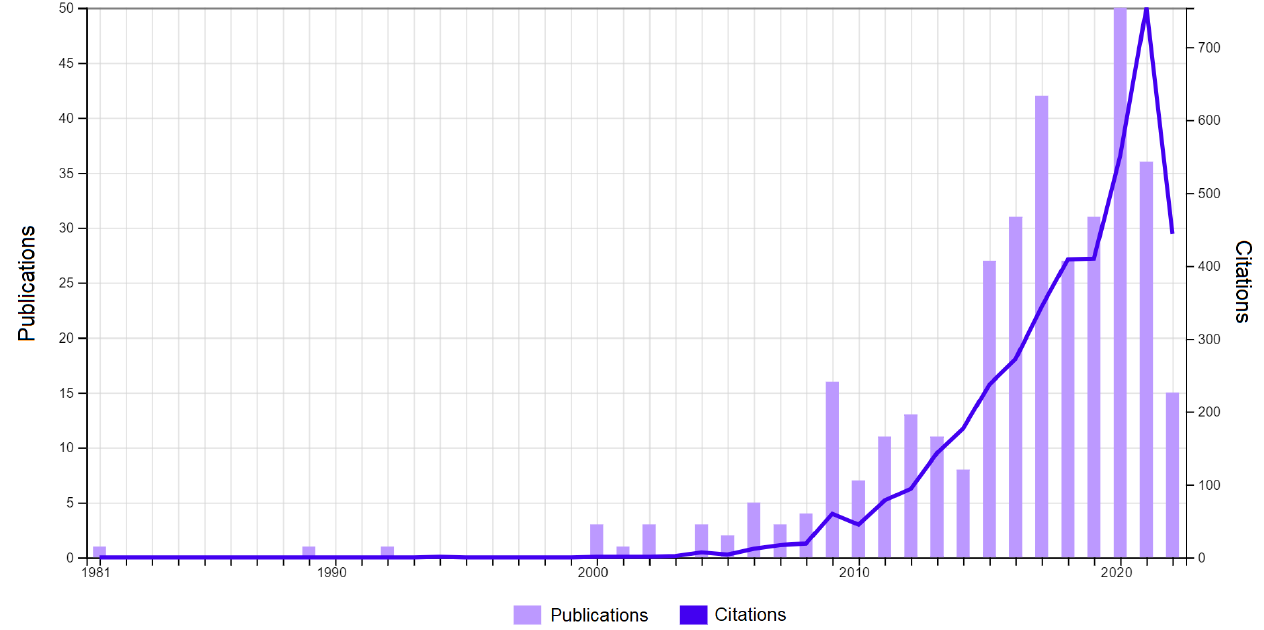
Figure 6. Statistics of publications related to desalination in Mexico [51].